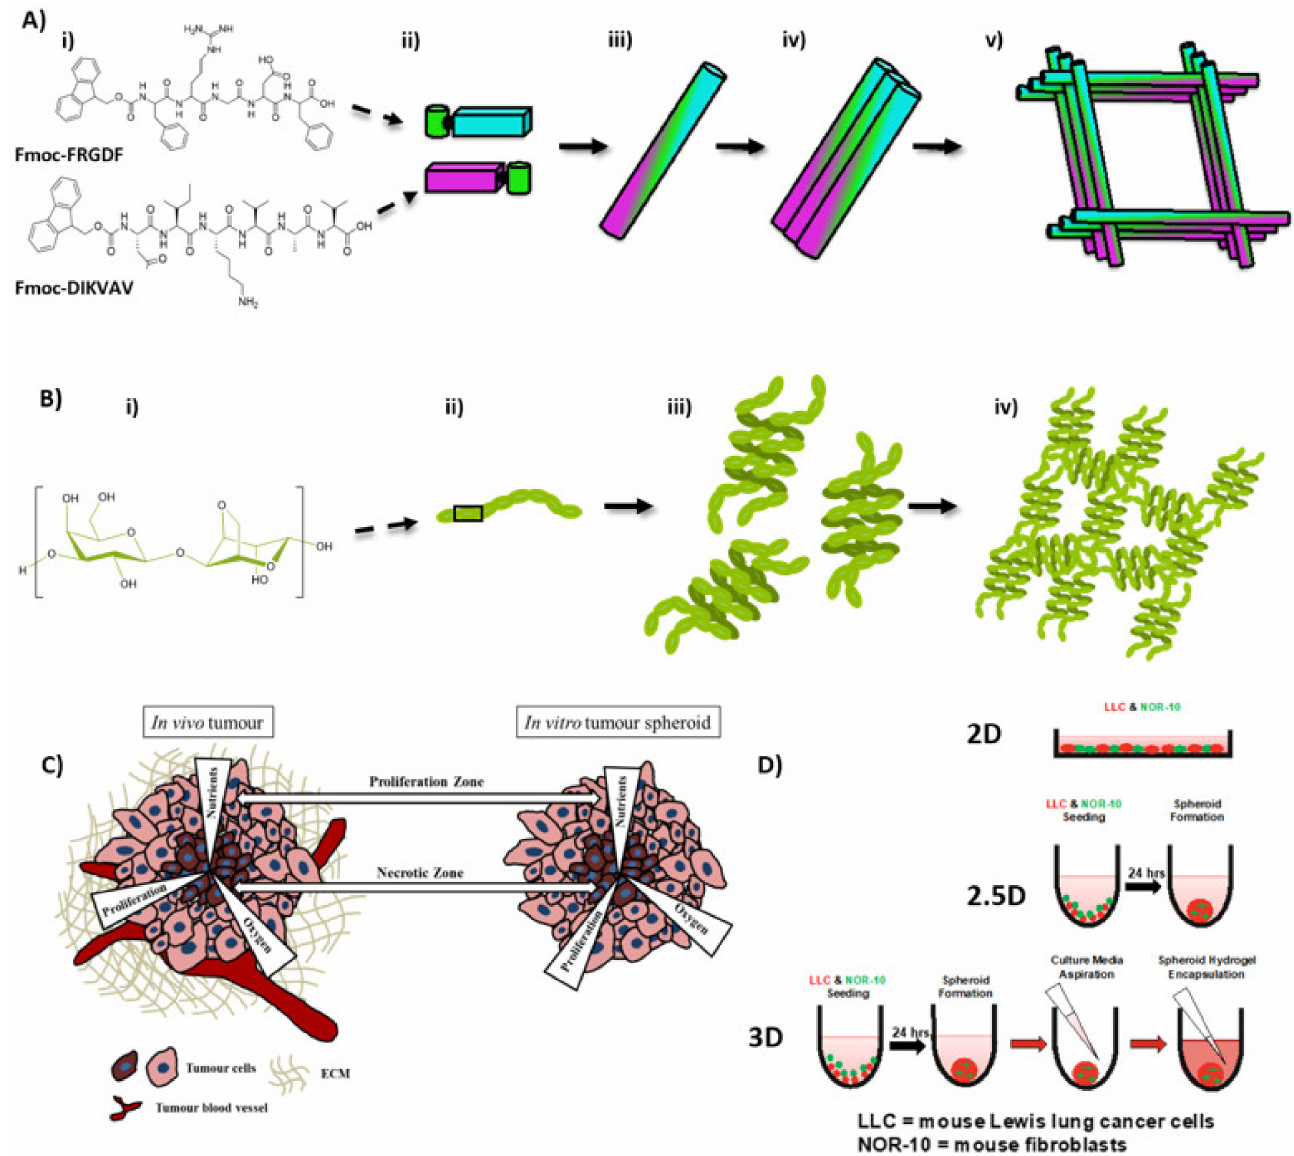
Figure 1. Illustration of Fmoc-SAP and agarose hydrogel self-assembly, and schematic illustration of common features demonstrated by solid tumour in vivo and the in vitro tumour spheroid ( A ) Cartoon depiction of Fmoc-SAP hydrogel formation (i) Each single SAP consists of an Fmoc aromatic group coupled with a short amino acid sequence. (ii) Under physiological conditions, self-assembly is initiated through stacking. (iii) Peptides align to form individual nanofibres. (iv) Nanofibres bundle together. (v) Bundles associate and intertwine to form the hydrogel network. ( B ) Cartoon depiction of agarose hydrogel formation. (i) Chemical structure of agarose. (ii) Artistic depiction of polymer. (iii) Formation of helical structures (iv) Polymer association and formation of network. ( C ) Common features between solid tumours in vivo and tumour spheroids in vitro include a central necrotic zone, due to the decreased availability of oxygen, nutrients and space for proliferation, and an outer proliferation zone. ( D ) Schematic representation of cell growth in the three microenvironments investigated: as a monolayer in 2D tissue culture plates, 2.5D spheroid growth in culture media (i.e., no hydrogel encapsulation), and 3D spheroid growth encapsulated within Fmoc-FRGDF/Fmoc- DIKVAV hydrogels.